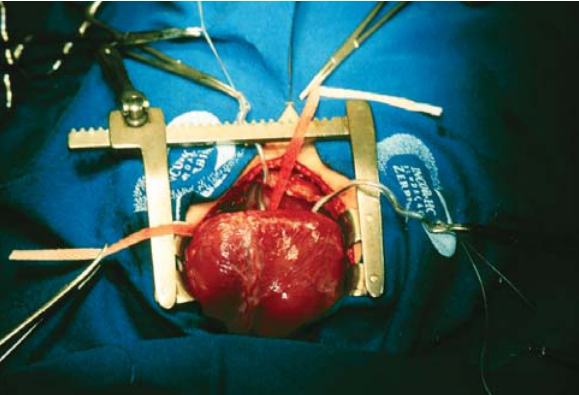
Fig. 1 - Exposição da parede diafragmática do coração por meio da técnica da sutura única